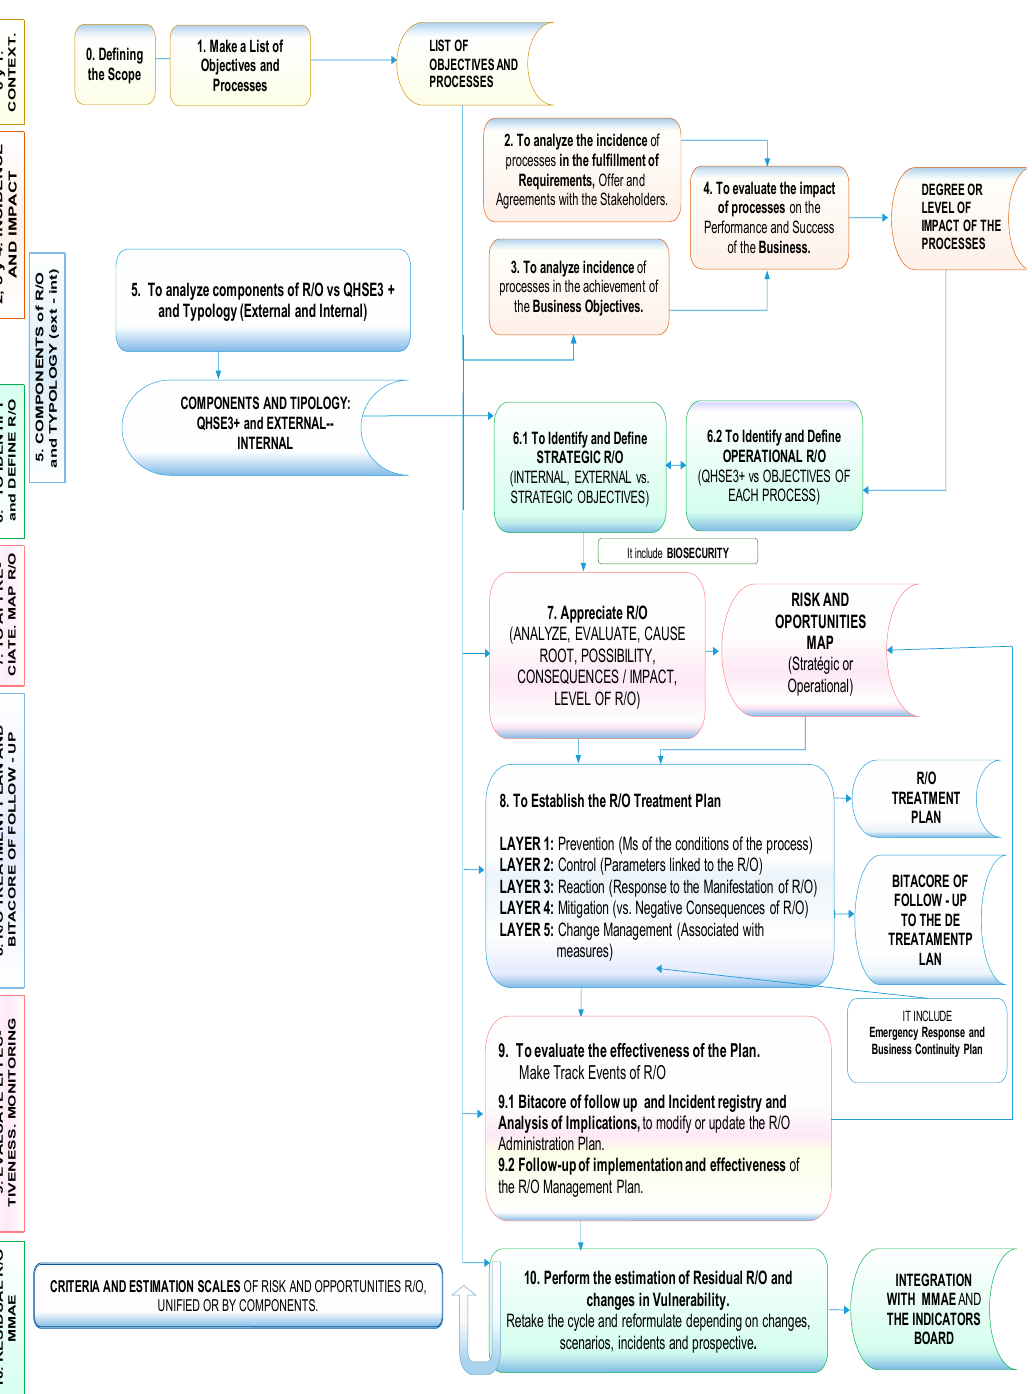
Figure 9. Parameterization of the application of the comprehensive R/O management model.